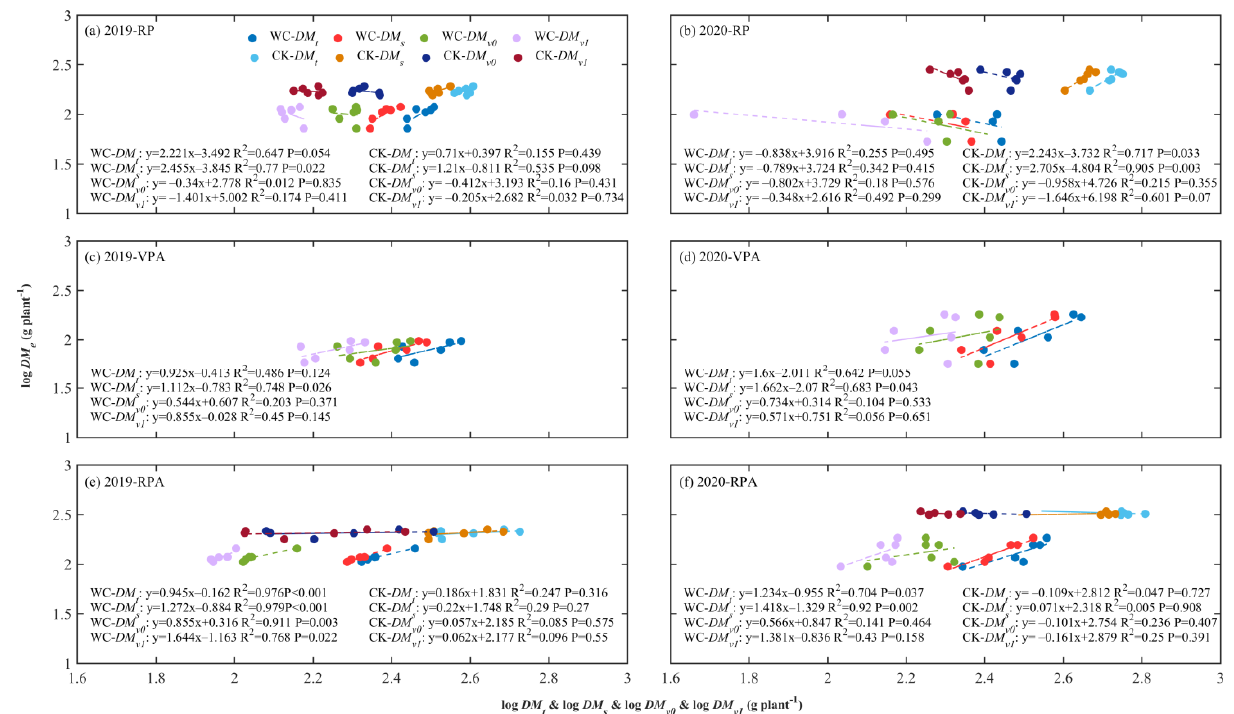
Figure 4. The ARs between ear and various parts of maize in 2019 and